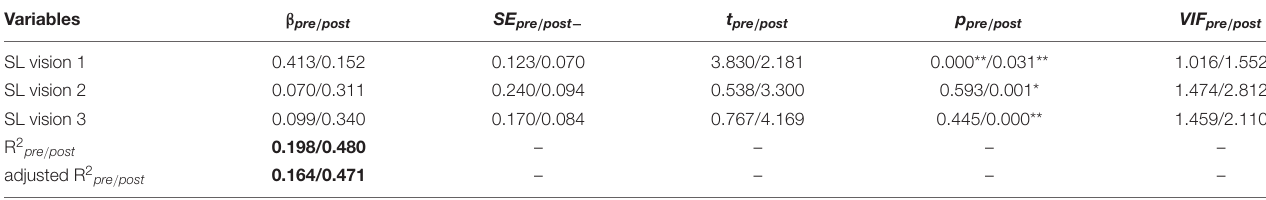
TABLE 2 | Pre-post comparison regression analysis—scientific literacy for transformative engagement for climate